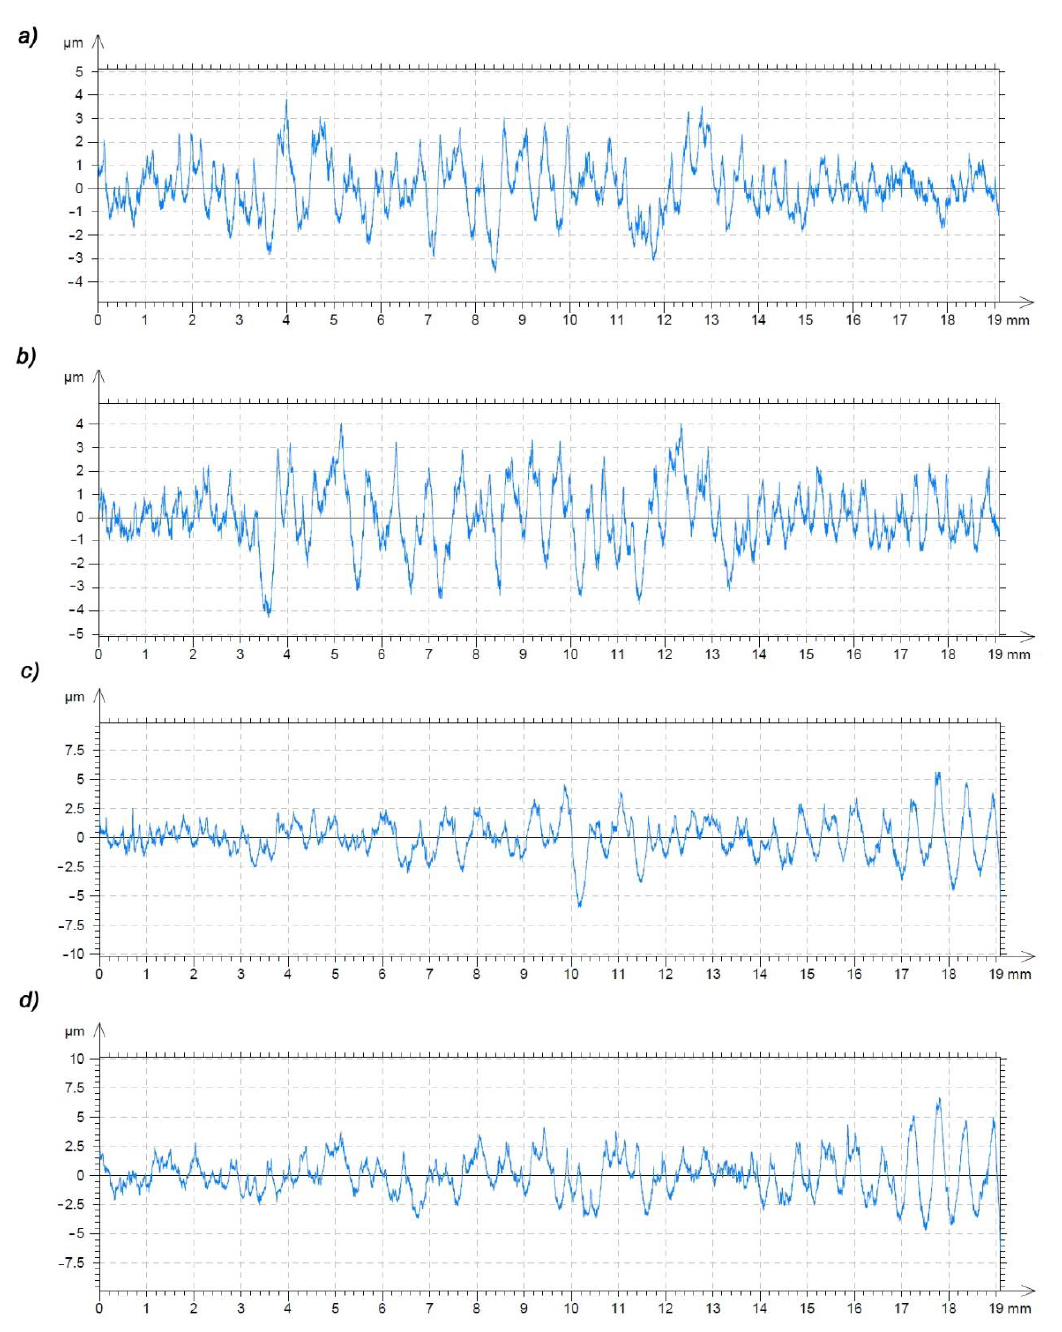
Figure 17. Profile of the roughness parameter R a measured along the tooth line for the size of the feed parameters: ( a ) 2000 (mm/min), ( b ) 2600 (mm/min), ( c ) 3200 (mm/min), ( d ) 4000 (mm/min); PVDA after heat